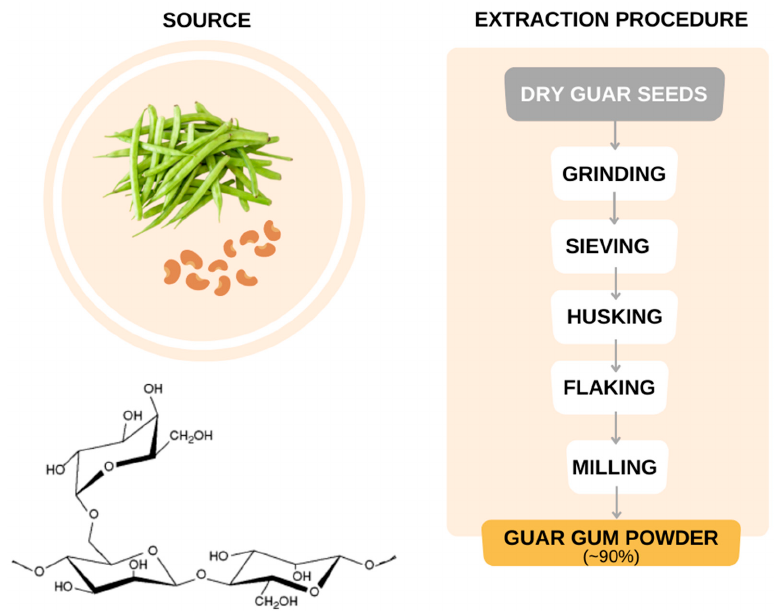
Figure 12. Guar gum: origin, extraction procedure, and chemical structure (Adapted with permission from Ref. [161] . Copyright 2016, Elsevier.